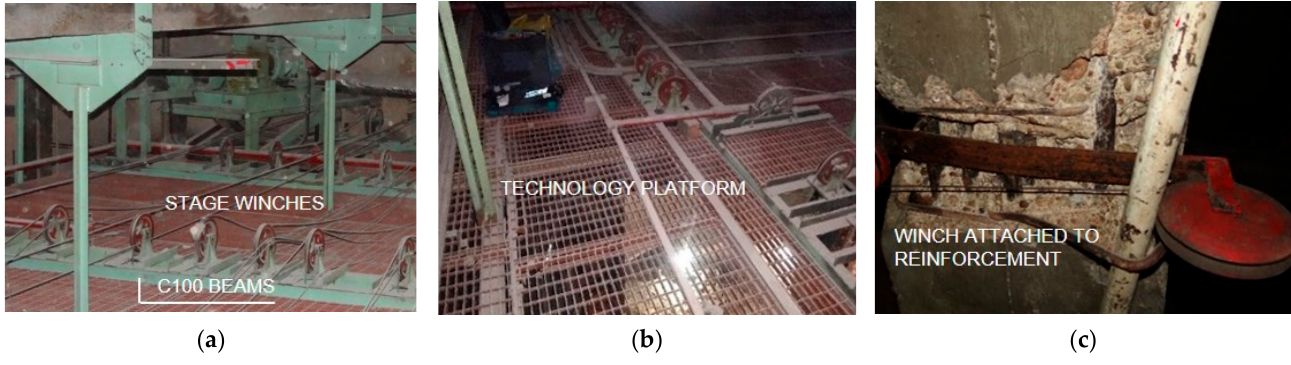
Figure 3. View of the technological platform: ( a ) winches: ( b ) the platform grid: ( c ) elements attached to the lower reinforcement of the beams.